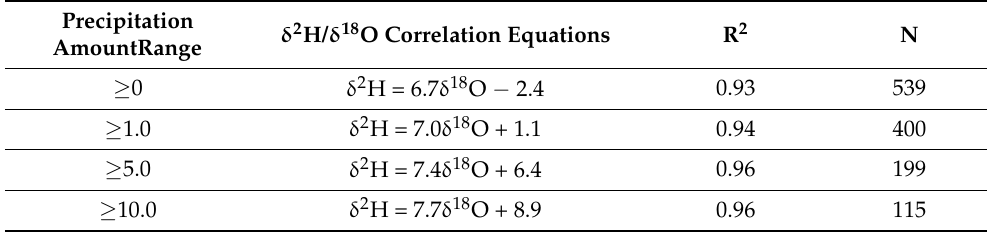
Table 2. Correlation equations for δ 2 H and δ 18 O values of individual precipitation samples with different precipitation amount ranges in Beijing,